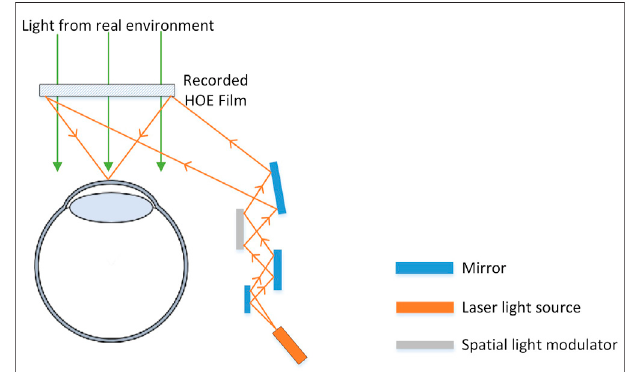
FIGURE 6 | Schematic illustration of a holographic AR NED design whichincludesthreecomponents:alaserlightsource,arecordedHOE fi lmas the optical combiner and a SLM. The laser light source is deployed to emit the light source; the SLM is utilized to generate the digital hologram pattern calculated for the 3D image to be displayed; and the recorded HOE fi lm is utilized to reconstruct the virtual image via off-axis projection.